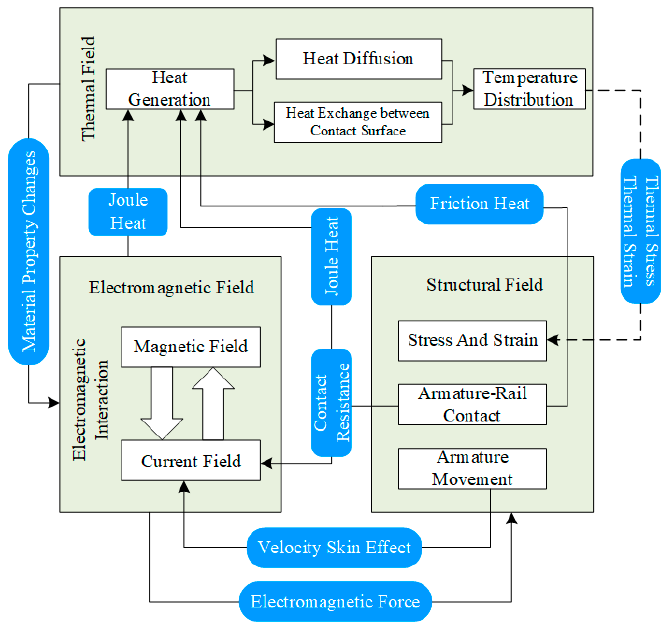
Figure 2. Coupling relationship of the model.